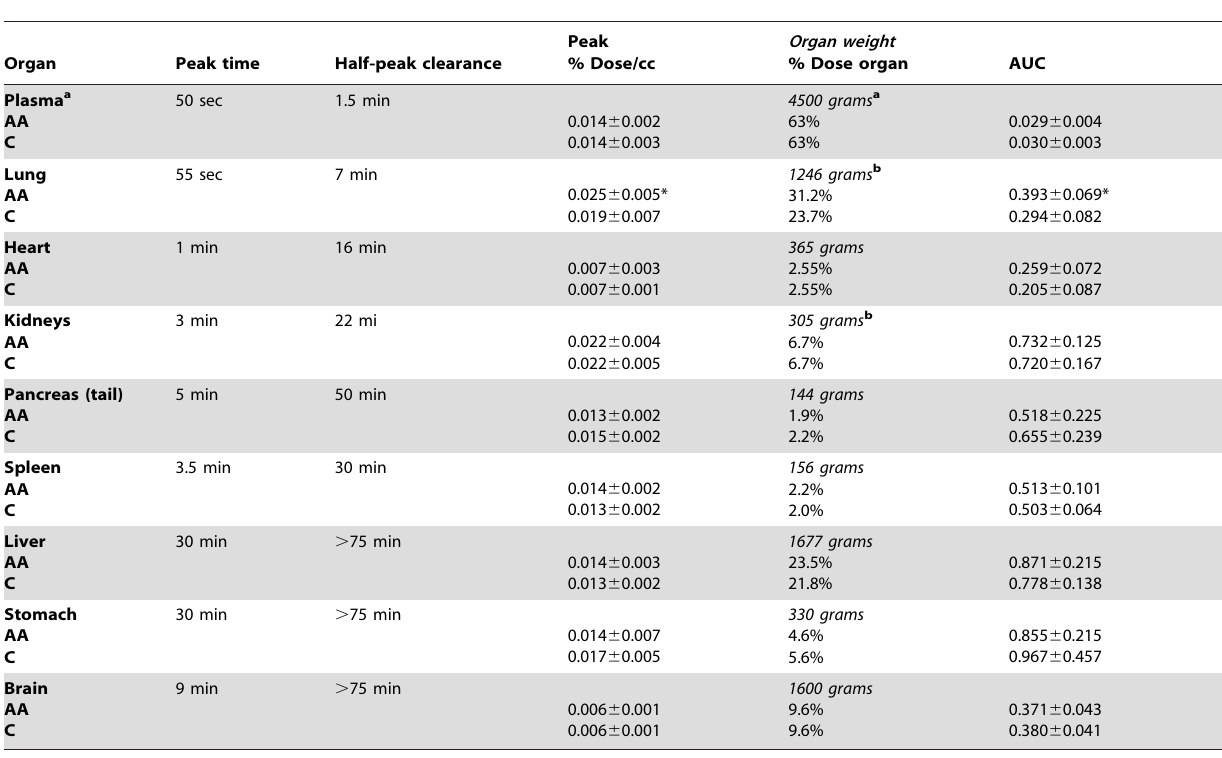
Measures correspond to: time to peak concentration (Peak time), time to half-peak clearance averaged across both groups and peak concentration (expressed as % dose per cc) and AUC for the time activity curves for the African Americans (AA) and for the Caucasians (C). *Unpaired Student t test (two tail) p , 0.05. a The plasma value was extrapolated to whole blood assuming a 55% plasma volume. b Reflects the total weight of both left and right organs. Note that the total percent of organ accumulation is greater than 100%; this is because the times at which the peak uptake and the clearance occurs differs among the organs. The weight of the organs corresponds to the average weights recorded from male autopsies [37]; except in brain, which corresponds to weights obtained with MRI 38 .